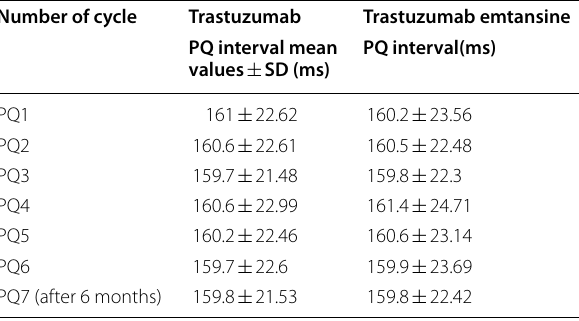
There were no significant changes in the PQ interval duration, neither in relation to subsequent trastuzumab applications nor 6 six months after the last cycle. Comparable to trastuzumab, no significant changes of the PQ interval were found neither in relation to trastuzumab emtansine cycles, nor six months after the last application of the drug (Table 1)